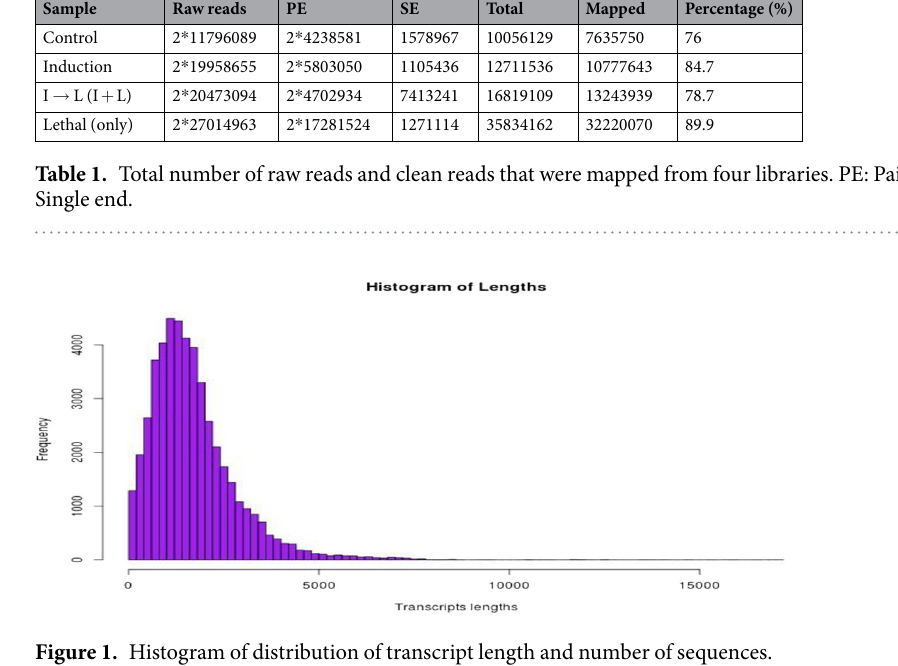
Figure 1. Histogram of distribution of transcript length and number of